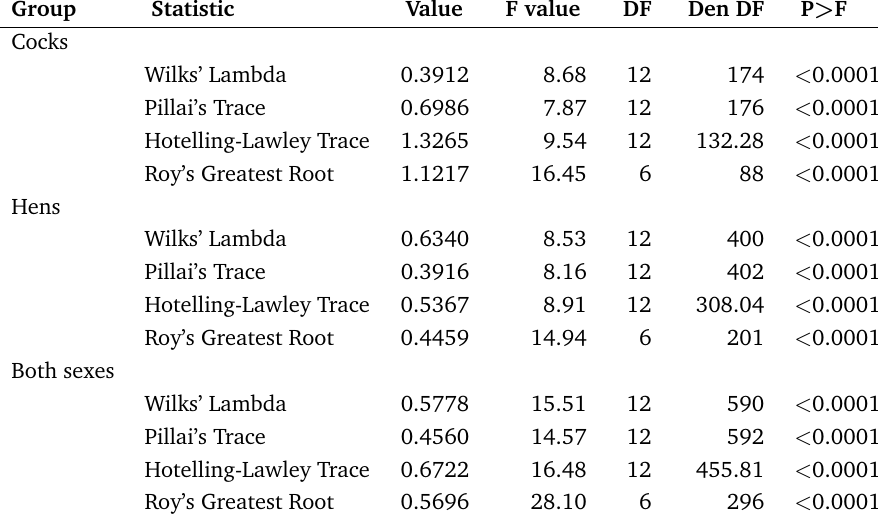
Table 9. Multivariate statistics and F approximations used in discrimination of the chicken populations. DF = degrees of freedom; P =